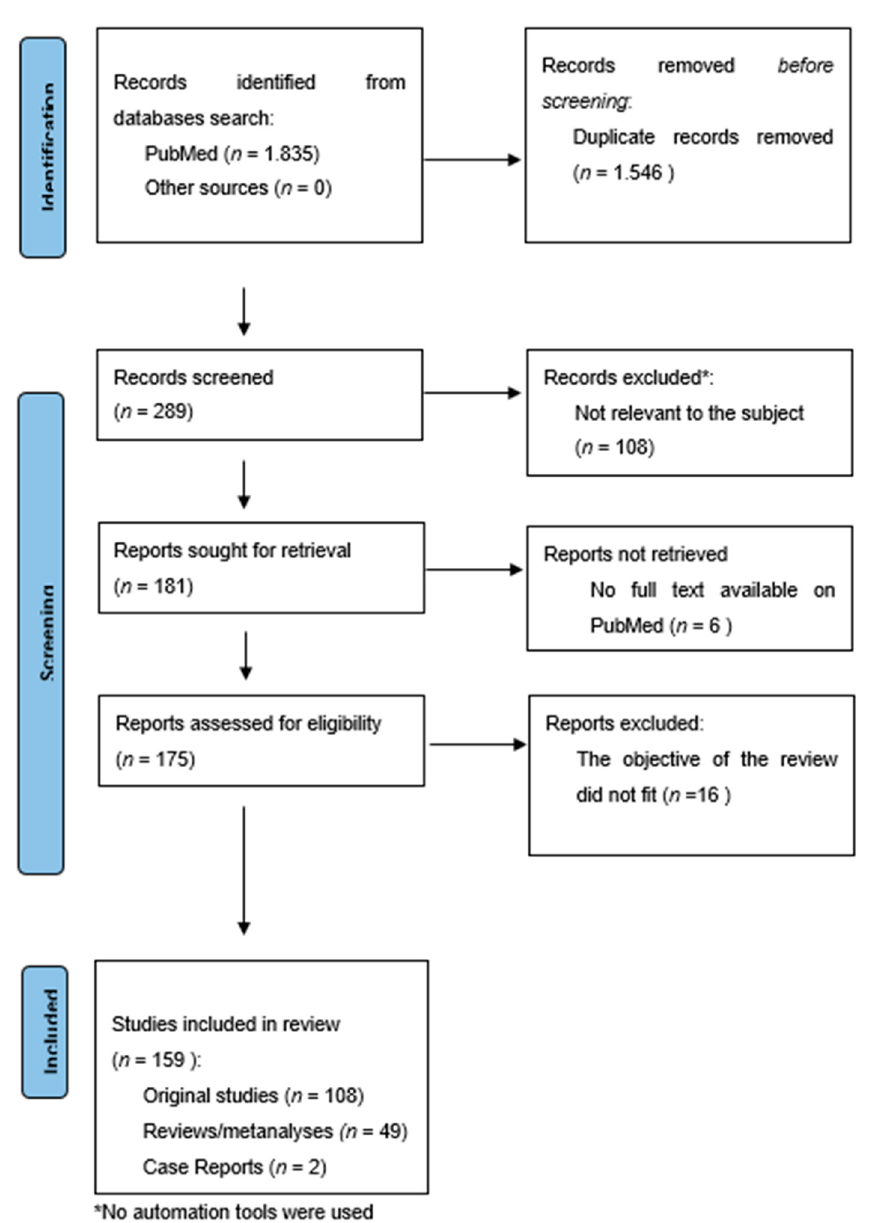
Figure 1. Flow chart according to the PRISMA Statement [34].